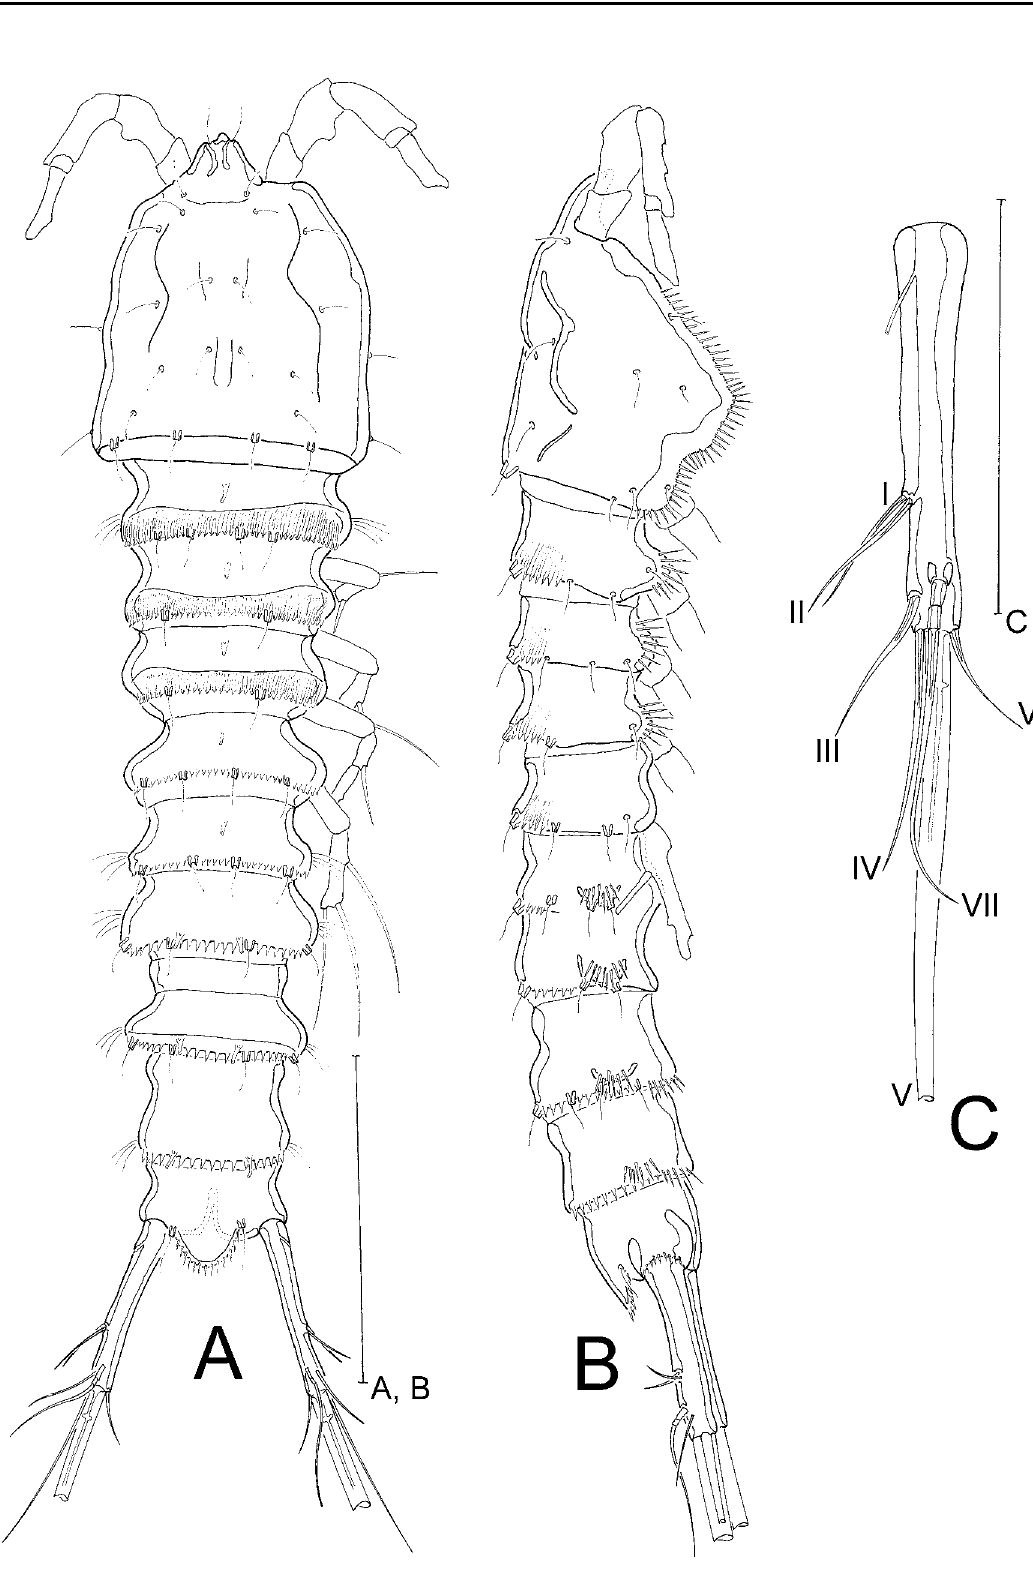
Fig. 2. Laophontodes typicus T. Scott, 1894. A–C . Habitus ♀ (BMNH 2015.1144–1153-1). A . Dorsal view. B . Lateral view. C . Left furcal ramus, dorsal view. Scale bars: A–B = 100 µm, C = 50